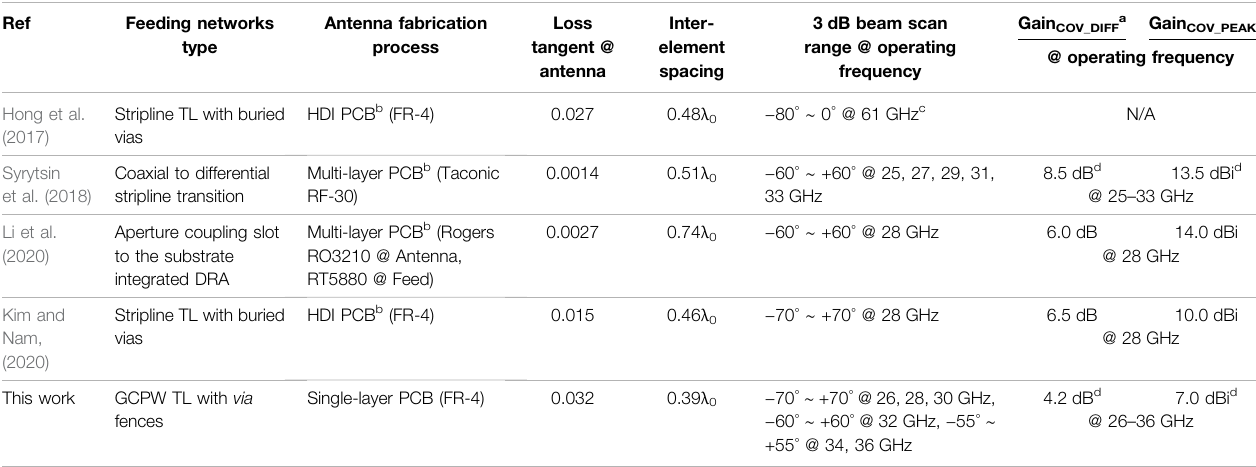
TABLE 2 | Comparison of the state-of-the-art mm-wave phased arrays mounted on edge of mobile